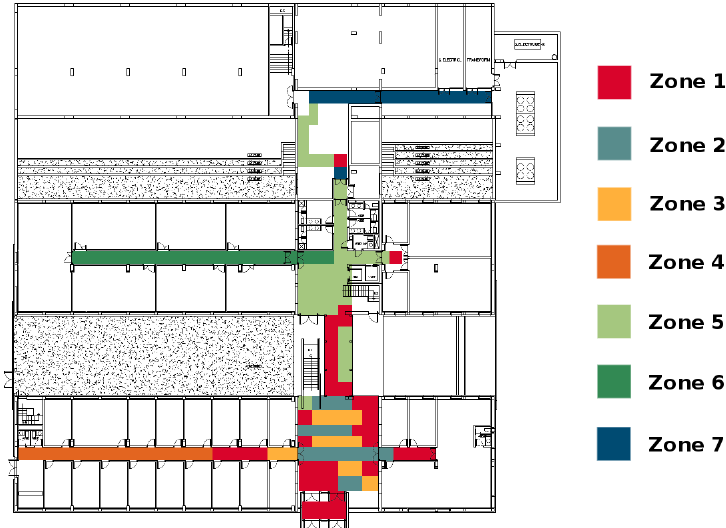
Figure 10. Zones in Building B identified with the EM algorithm using the intensity parameter of the magnetic field.